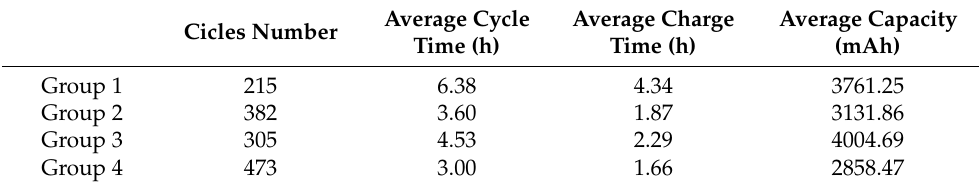
Table 6. Average measurements of the four battery